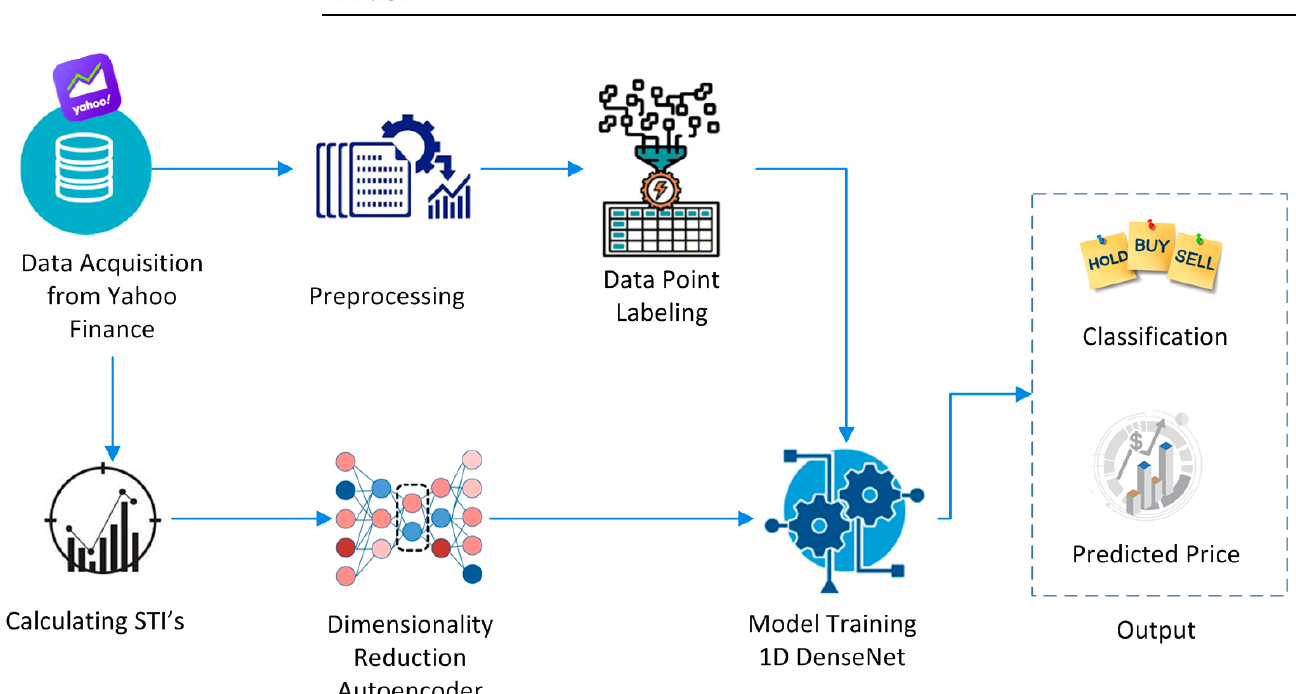
Figure 1. Proposed methodology AEI-DNET. Algorithm 1: Steps for Stock Market Prediction.